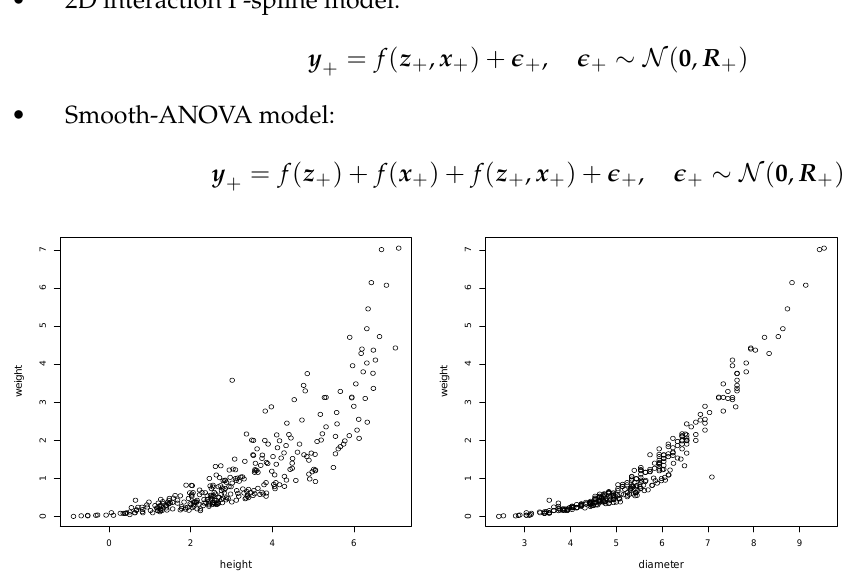
Figure 4. Plot of weight versus height ( left ) and plot of total weight versus diameter ( right ). We have predicted weights for 10 new out-of-sample values for diameter and